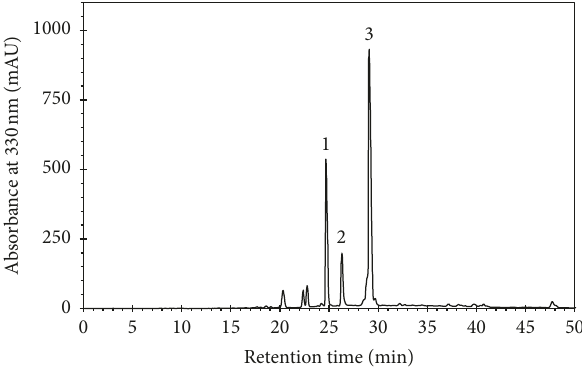
Figure 1: HPLC chromatogram of the phenolic compounds present in the perilla